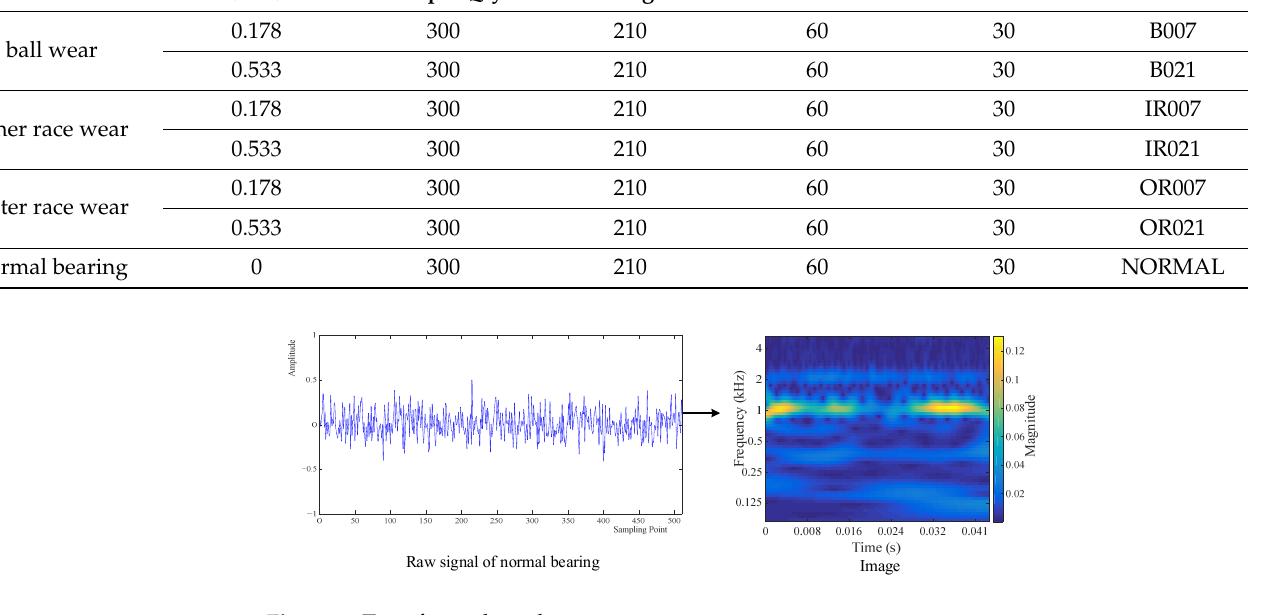
Figure 8. Transformed result.